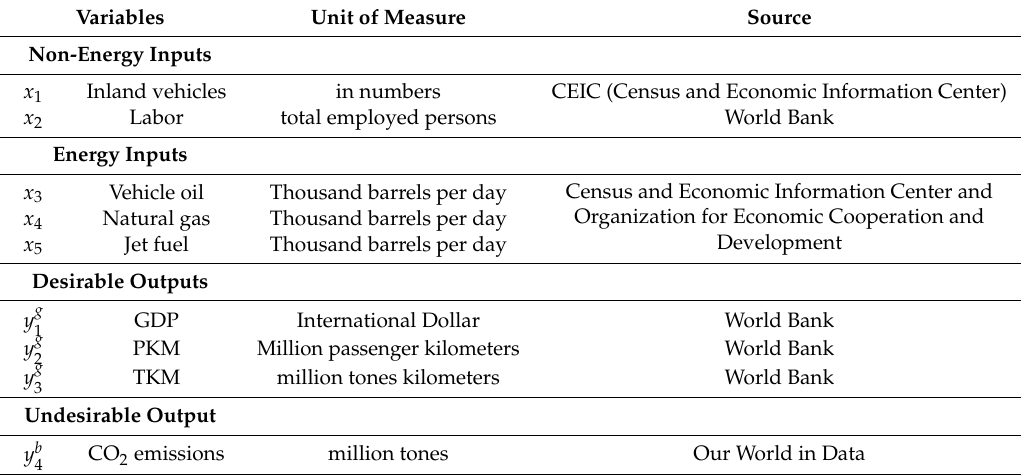
Table 3. Selected inputs and outputs for transport energy e ffi ciency